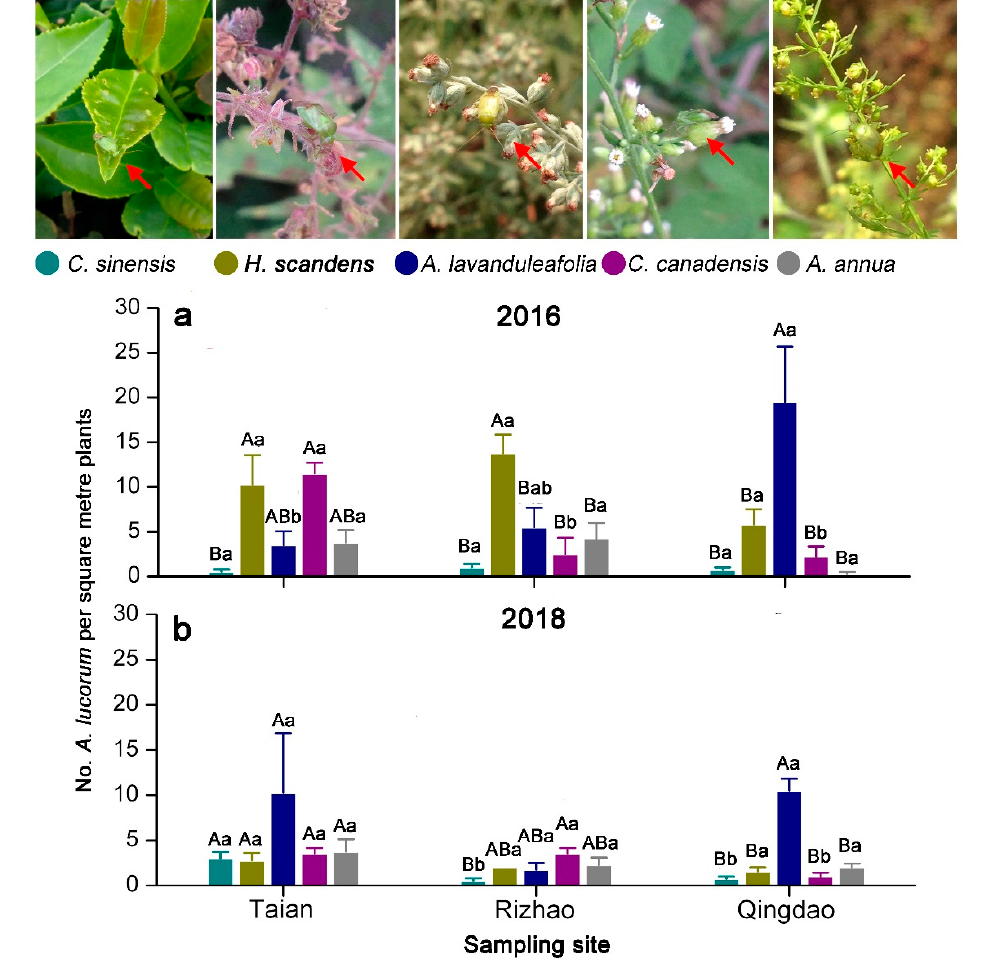
Figure 3. Number of Apolygus lucorum on Camellia sinensis , Humulus scandens , Artemisia lavandulaefolia , Conyza canadensis , and Artemisia annua in tea plantation in di ff erent tea-producing areas in 2016 ( a ) and 2018 ( b ). Di ff erent uppercase and lowercase letters indicate significant di ff erences among di ff erent tea-producing areas and di ff erent mirid bug species, respectively (Tukey’s HSD test, p < 0.05). The red arrows indicate A. lucorum on tea plants and four weed host plants at flowering stage.